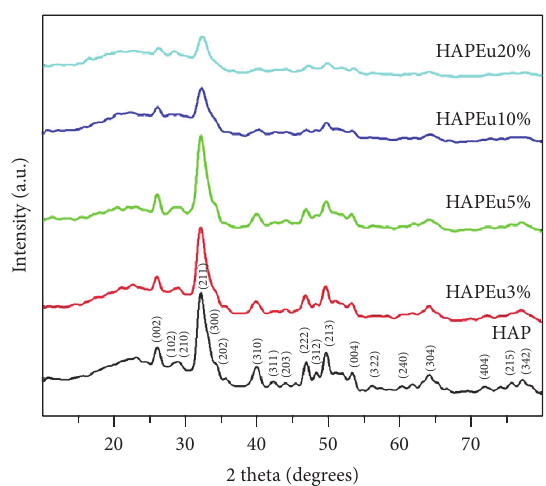
Figure 1: X-ray diffraction patterns of the pure HAP and Eu-doped HAP. Samples can be indexed as pure hexagonal phase (P6 3 /m space group).